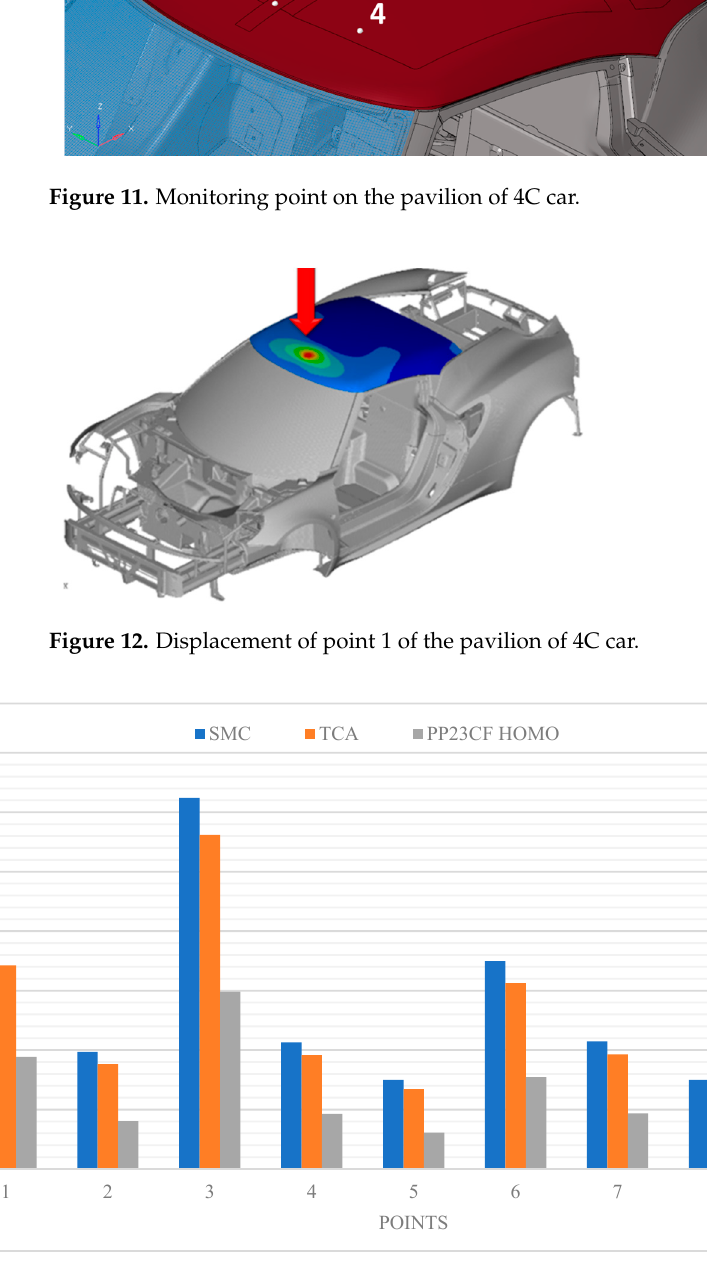
Figure 13. Static stiffness for every single point (see Figure 11) and material under analysis.